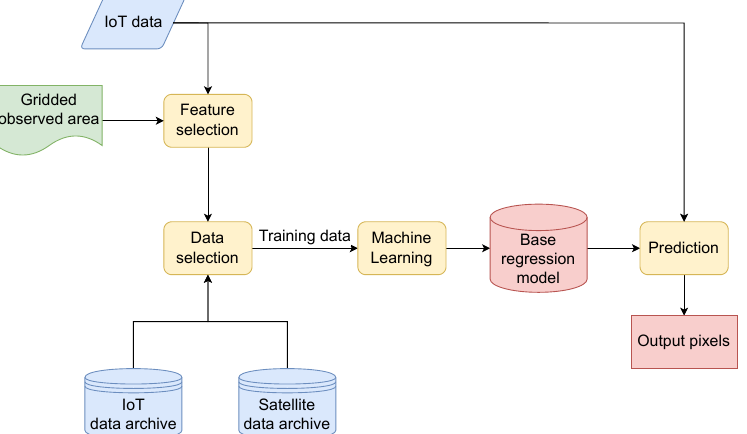
Figure 1. The architecture of the proposed method.